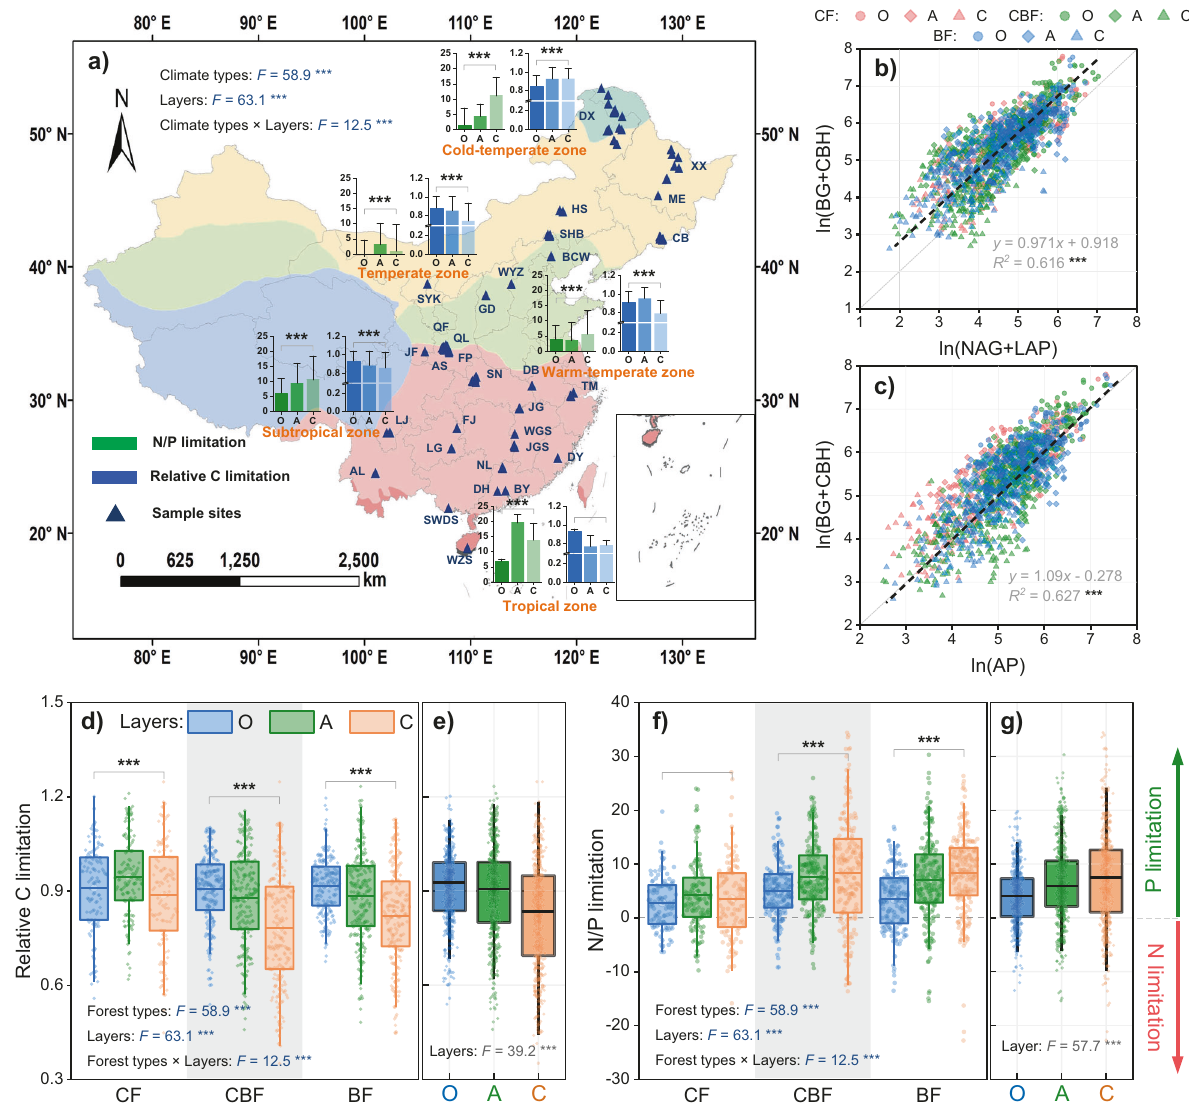
Fig. 1 Spatial patterns of relative C limitation and N/P limitation of soil microbial metabolism in Chinese forests. a Geographical distribution of 181 Chinese forest study sites, the effects of both climate types and soil layers on relative C limitation and N/P limitation. b , c Identi fi ed relationships between C-acquiring enzyme activities and N-acquiring or P-acquiring enzyme activities in Chinese forests ( n = 1520) via standardized major axis (type II) regression. The 1:1 dotted line is gray. *** represents signi fi cant relationships at P < 0.001. d , f The effects of soil layers within forest types on relative C limitation and N/P limitation. e , g The overall effects of soil layers on relative C limitation and N/P limitation in Chinese forests. The effects of climate, forest type and soil layers on microbial metabolic limitations were analyzed via linear mixed-effects models. *** represent signi fi cant effects at P < 0.001. The asterisk above the bar and box charts represents the signi fi cance of the effects of soil layers within climate ( a ) and forest ( d , f ) types on relative C limitation and N/P limitation. In the box charts: the top of box is 75 th percentile, the center of box is median, the bottom of box is 25 th percentile, and the upper and lower ends of the vertical line are the maximum and minimum data values, respectively. Soil layers: O, organic horizon; A, eluvial horizon; C, parent material horizon. Vegetation types: CF coniferous forest, CBF coniferous-broadleaf mixed forest, BF broadleaf forest. C-acquiring enzymes: β − 1,4-glucosidase (BG) and cellobiohydrolase (CBH)), N-acquiring enzymes: β − 1,4- N -acetylglucosaminidase (NAG) and L-leucine aminopeptidase (LAP), and P-acquiring enzyme: alkaline or acid phosphatase (AP). The full names of all 31 mountain forests sampled (DX, XX, ME, etc.) are listed in Supplementary